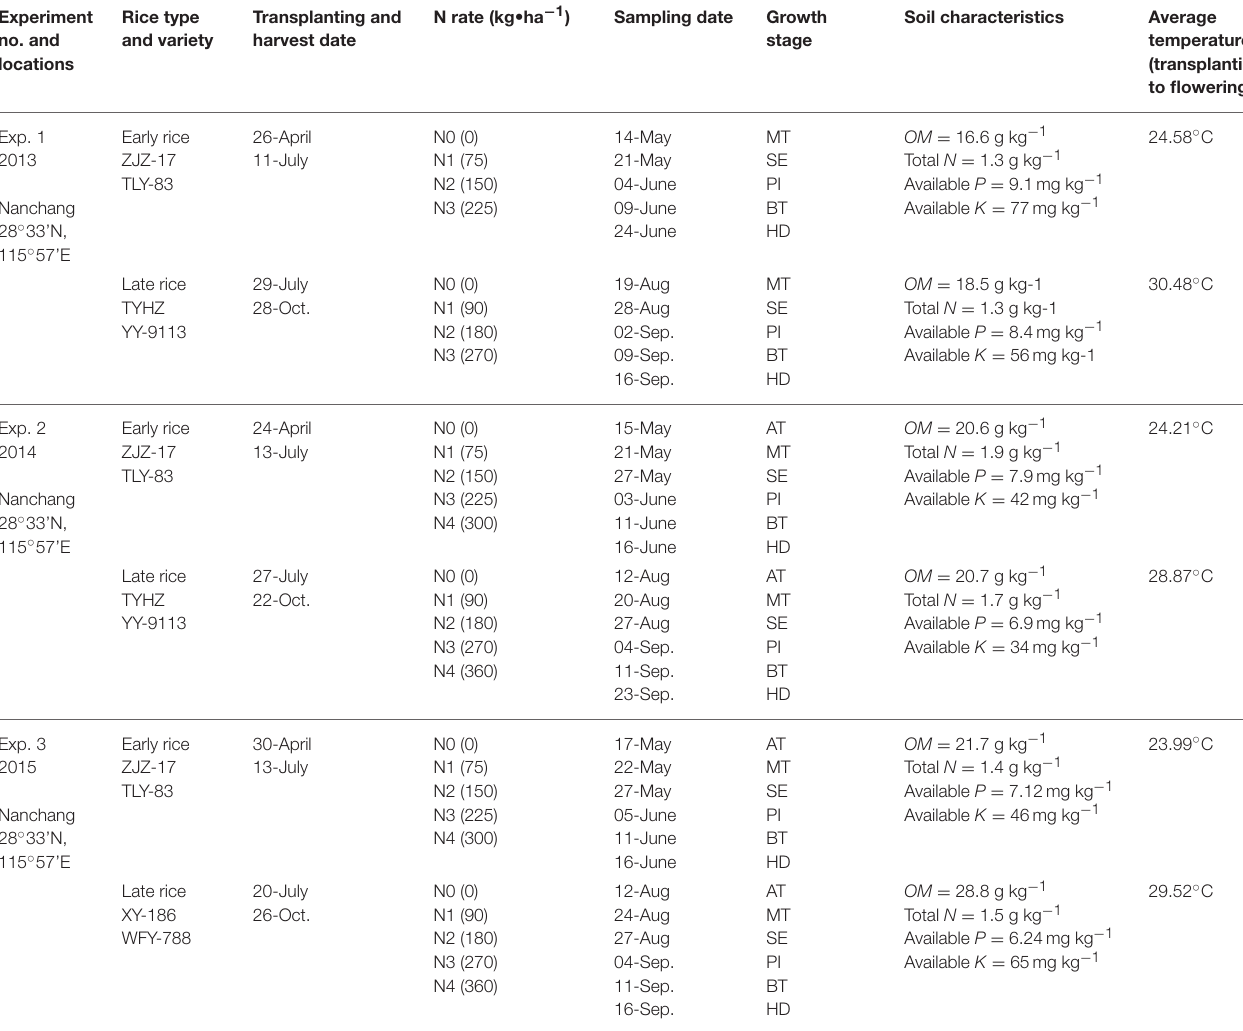
samples were oven-dried at 105 ◦ C for 30 min to stop metabolism and then at 80 ◦ C until constant weight was reached to determine shoot biomass (t ha − 1 ). All samples were milled and analyzed for total shoot N concentration by the micro-Kjeldahl method.